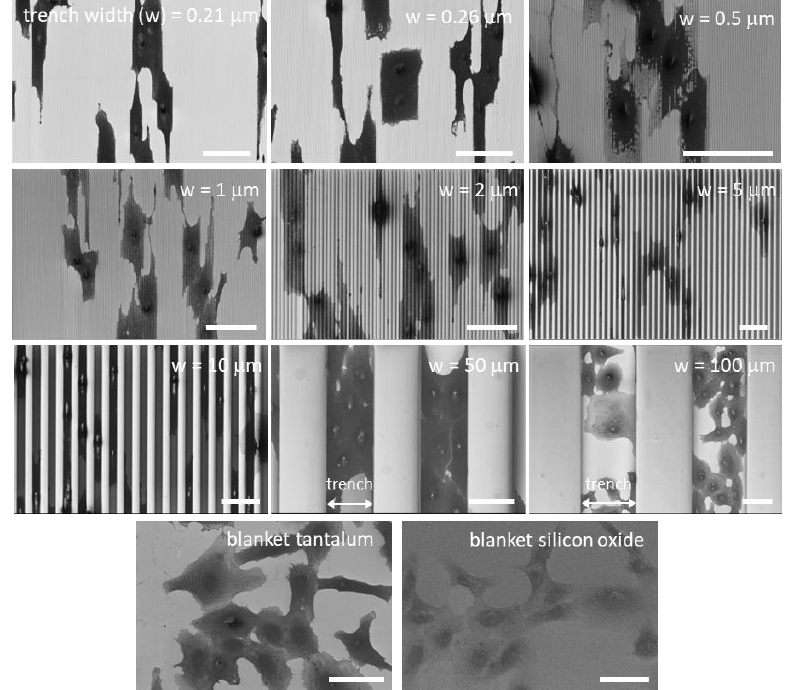
Figure 5. Typical top-down low-magnification scanning electron microscopy (SEM) micrographs of adherent cells on comb structures with various trench widths. Trench axes are in the vertical direction. Cells on blanket tantalum and silicon oxide films are also included. These micrographs show cells align with the trench axes on the comb structures. Cells preferentially adhered to tantalum surfaces on the 10, 50, and 100 μm comb structures. Scale bars correspond to 50 μm.